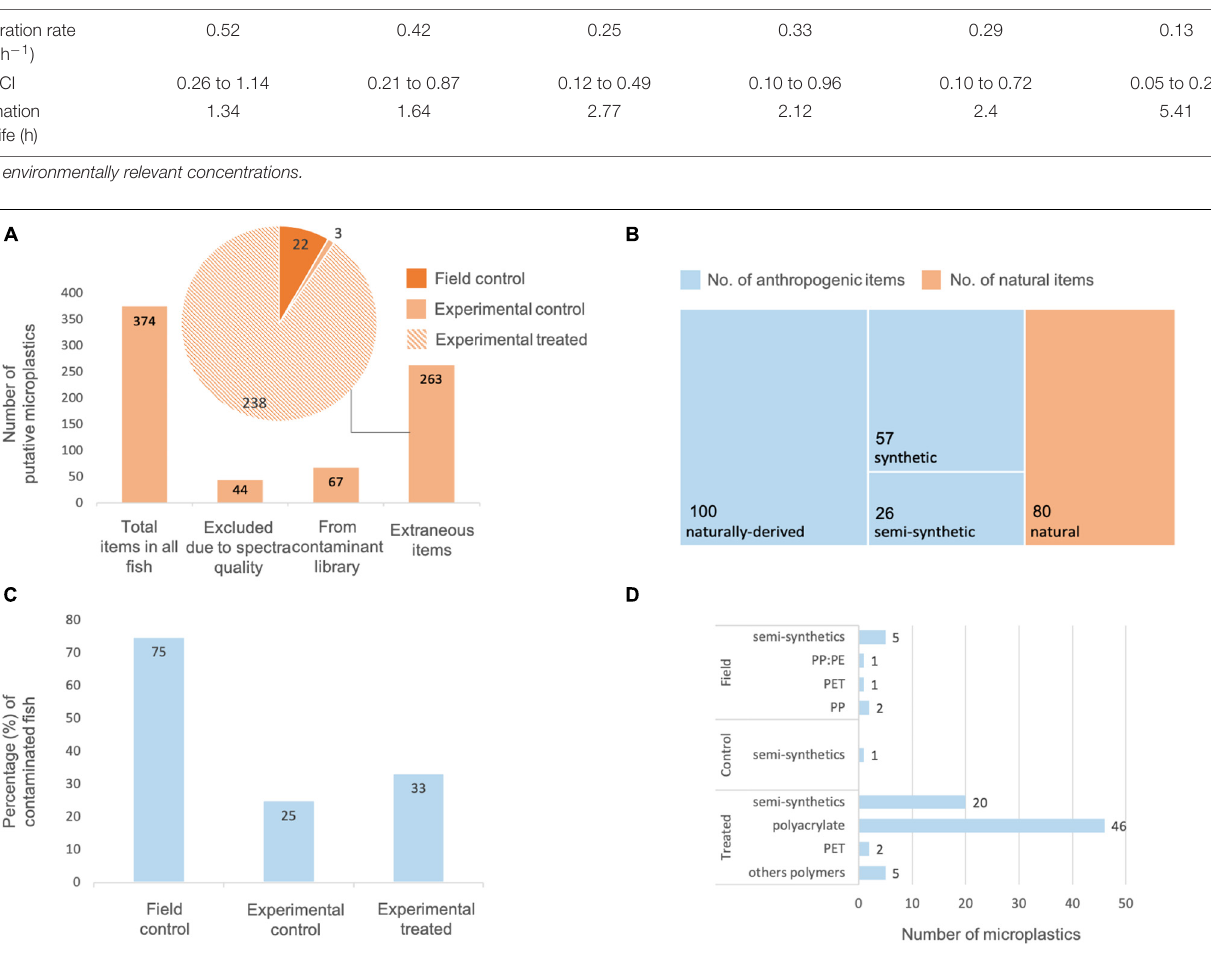
FIGURE 4 | Quantification and potential sources of extraneous microplastic contamination throughout a single exposure study of adult damselfish Pomacentrus amboinensis to polypropylene (PP) particles and polyethylene (PET) fibers in a controlled laboratory experiment. (A) Total number of putative microplastics visually identified in the fishes’ gastrointestinal tracts (GIT), with 67 items likely originating from sample processing procedures, and 263 items deemed to come from experimental system and procedures. (B) Assignment of 263 putative microplastics to natural, and anthropogenic – naturally derived, semi-synthetic, or synthetic items. (C) Percentage of field control, experimental control, and experimental treated fish contaminated with extraneous microplastics. (D) Polymer type and number of extraneous microplastics found in field control, experimental control, and experimental treated